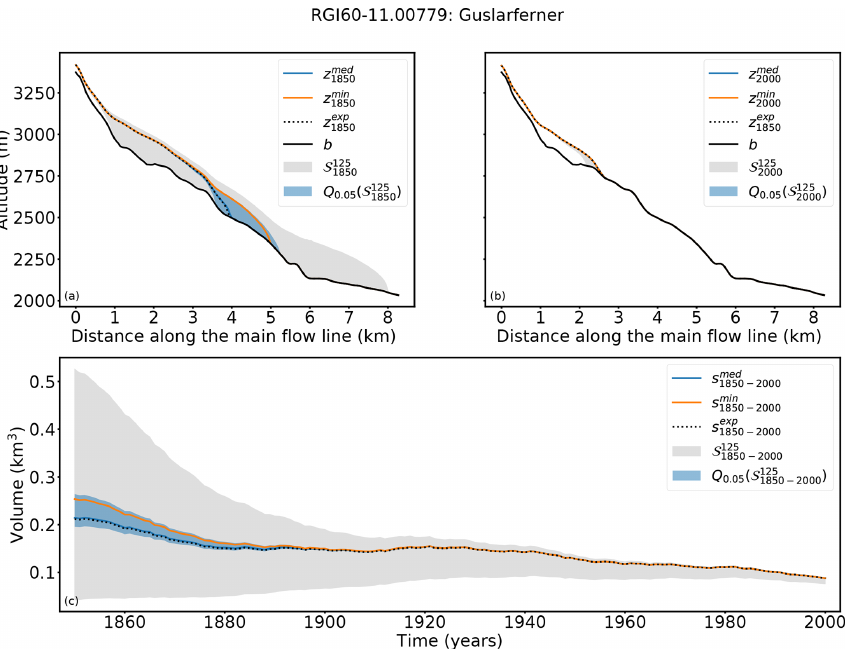
Figure 4. Results for Guslarferner (Ötztal, Austria). Cross sections along the main flow line in (a) 1850 and (b) 2000 are shown. (c) Volume changes from 1850 to 2000. The grey shaded area indicates the range of all solutions with a fitness value smaller than 1 ( S 125 t ). The blue shaded area shows the range of the 5th quantile of S 125 t , the blue line s med t , and the orange line s min t